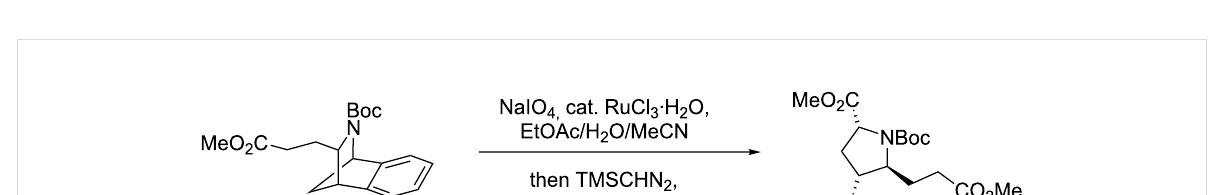
Scheme 7: Ring-opening–hydration–oxidation of azacycle 8 .